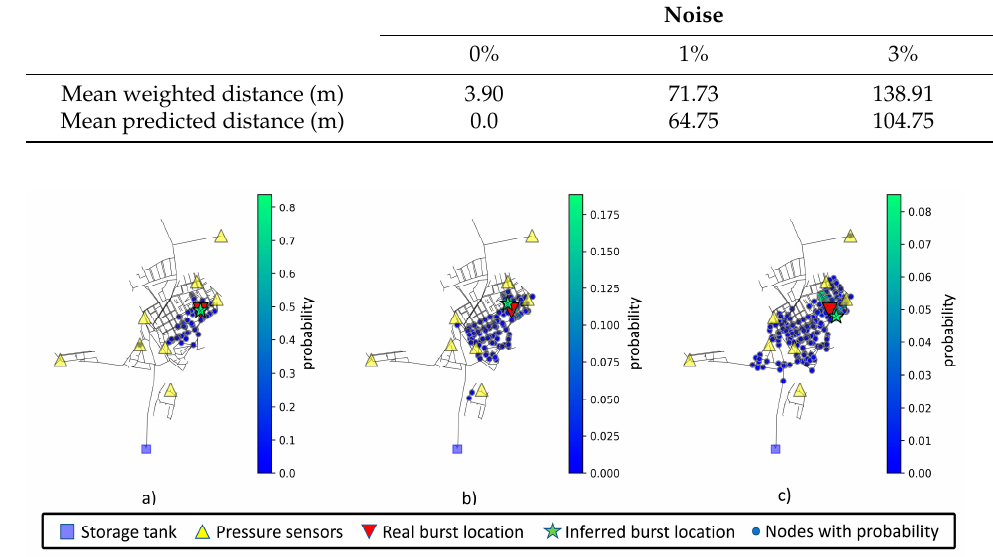
Figure 12. Network prediction areas for node 235, considering ( a ) 0% noise level, ( b ) 1% noise level, and ( c ) 3% noise level. Nodes with higher probability are displayed in a greener color and with lower probability in a bluer color, following the scale presented to the right of each chart.